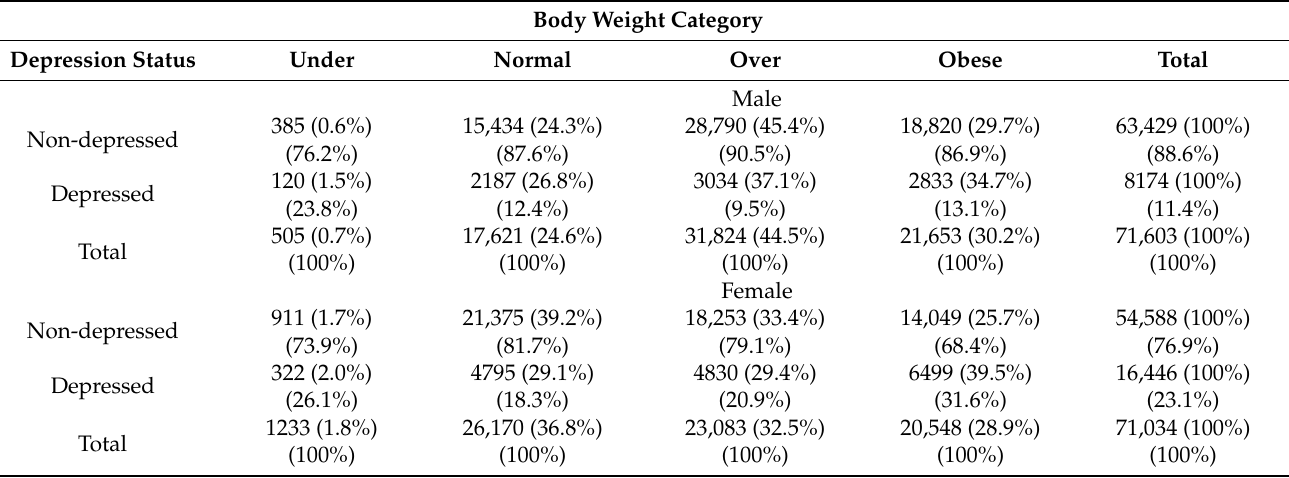
Table 1. Frequency distribution of depression and body weight categories. Body Weight